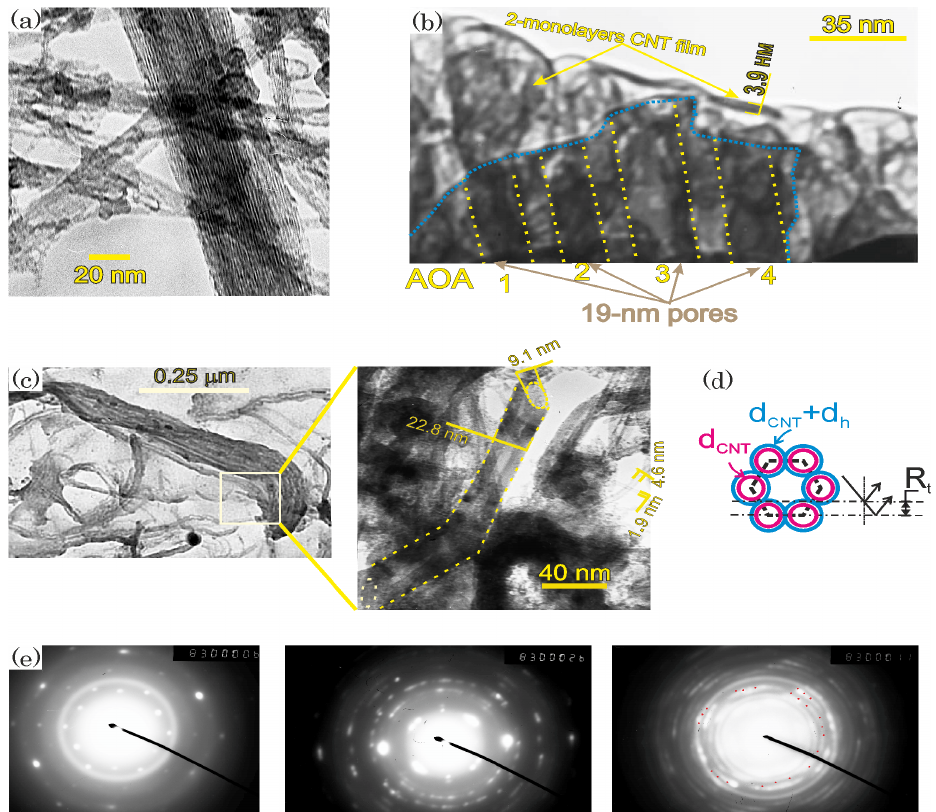
Figure 4. ( a ) TEM image of original carboxylated few-walled CNTs deposited on a copper grid at 270,000 × magnification. ( b – e ) TEM images ( b , c ) and microdiffraction patterns ( e ) of two- and three-monolayer CNT LB films and a scheme of the diffraction ( d ). The magnifications are 140,000 ( b ), 19,000 ( c , left), and 190,000 ( c , right) times the original size. The CNT bilayers are arranged on the following supports previously covered by five ( b , d , left and middle) or three ( c ) Fe(II)DTP monolayers: a fresh cleavage of AOA with a pore diameter of 19 nm ( b ) and copper grids ( c , d ). The three-monolayer CNT film, whose diffraction pattern is presented in Figure d, right, was deposited on the grid without the Fe(II)DTP covering. The dashed yellow lines provide a guide to the eye for the 19 nm AOA pores in Figure b, and the blue curved line indicates the CNT bilayer edge ( b ). The elliptic 9.1 nm cross-sections of the thick CNT assembly are indicated by yellow ovals ( c ). The inset marked by yellow lines in ( c ), shows the thick and thin CNT assemblies with apparent diameters of 22.8 and 4.6 nm, respectively, and the CNT with an apparent diameter of 1.9